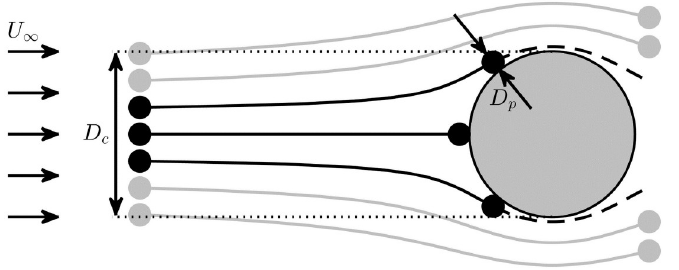
Fig 2. Plan view of particle capture through direct interception by a collector with diameter D c in an upstream flow velocity U 1 . Contact occurs when particle centers come within one particle radius of the collector surface (black particles). The contact efficiency of the collector ( η ) is the fraction of approaching particles that make contact (Eq 2); ‘approaching’ particles are those that flow through an upstream window of width D